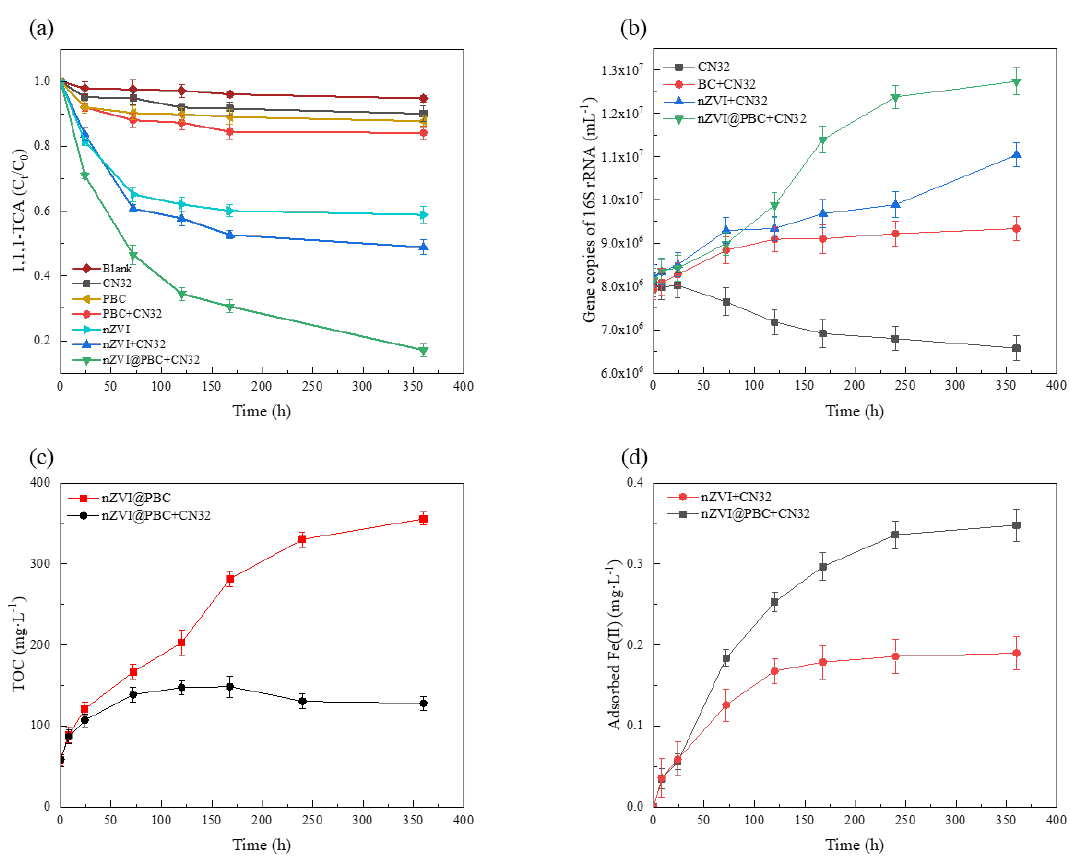
Figure 8. 1,1,1 − TCA removal performances ( a ), 16S rRNA copy numbers of CN32 ( b ), TOC concen- trations ( c ) and adsorbed Fe(II) concentrations ( d ) in nZVI@PBC + CN32 and other control treatments over